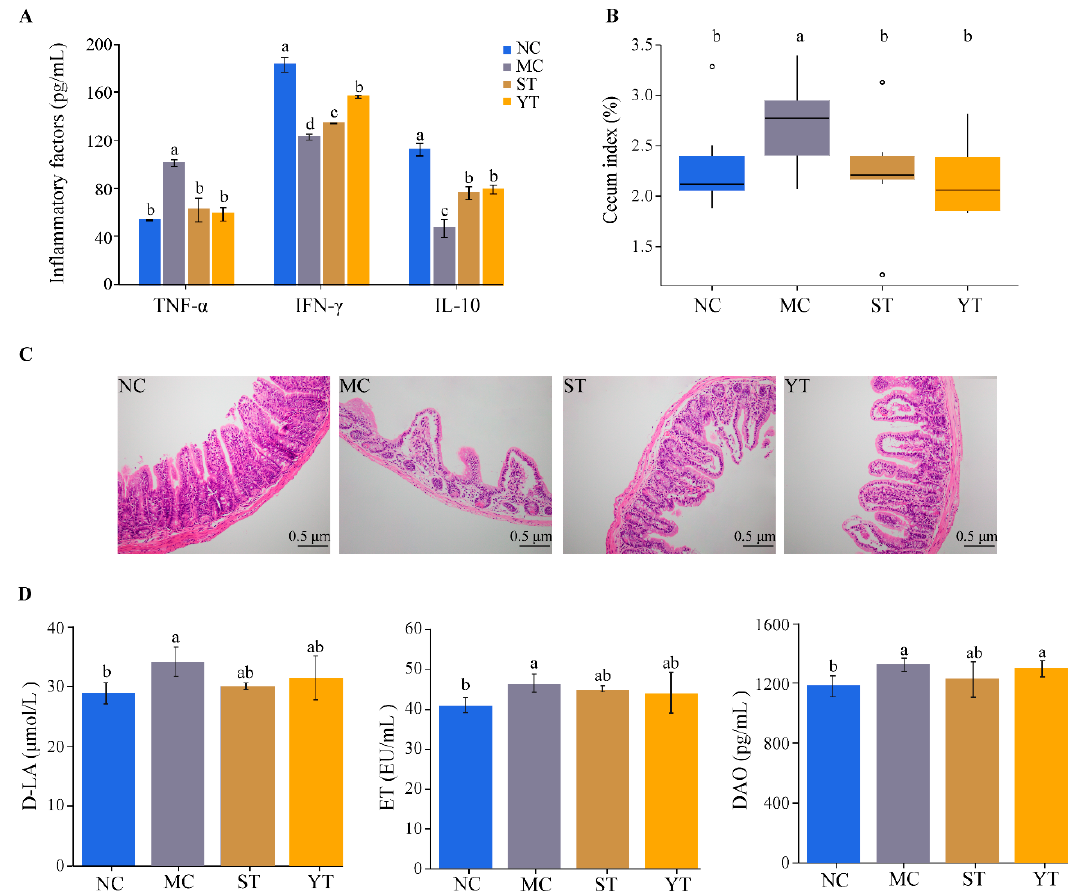
Figure 6. Effect of Streptococcus thermophiles DMST-H2 on inflammatory reaction and tissue damage. ( A ) Inflammatory factors (TNF- α , IFN- γ , IL-10) in the serum from each group. ( B ) Cecum index in each group. ( C ) Histological analysis of the ileum (200×). ( D ) Levels of D-LA, ET and DAO. NC, Normal control group ( n = 8); MC, Model control group ( n = 8); ST, DMST-H2 treatment group ( n = 8); YT, yogurt treatment group ( n = 8). Significance was set as p < 0.05, and values that do not share a common letter differed significantly ( p < 0.05).